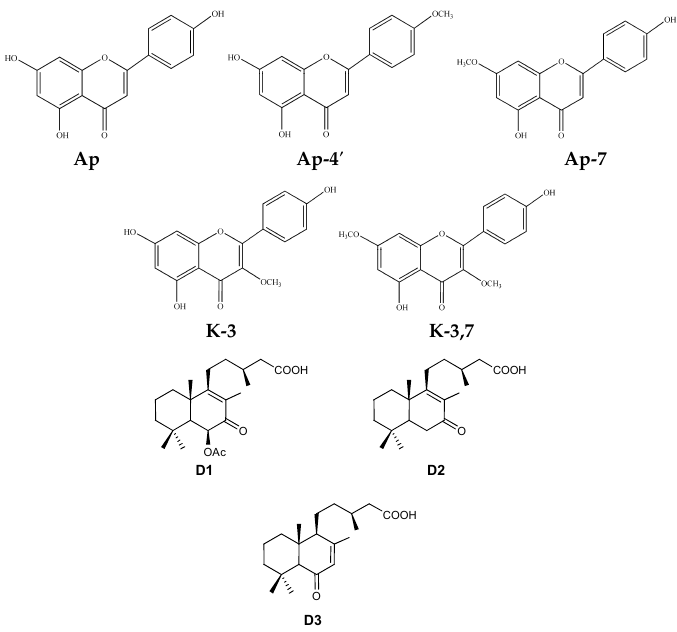
Figure 1. The chemical structures of flavonoids and diterpenes in the exudate of Cistus ladanifer . Ap :